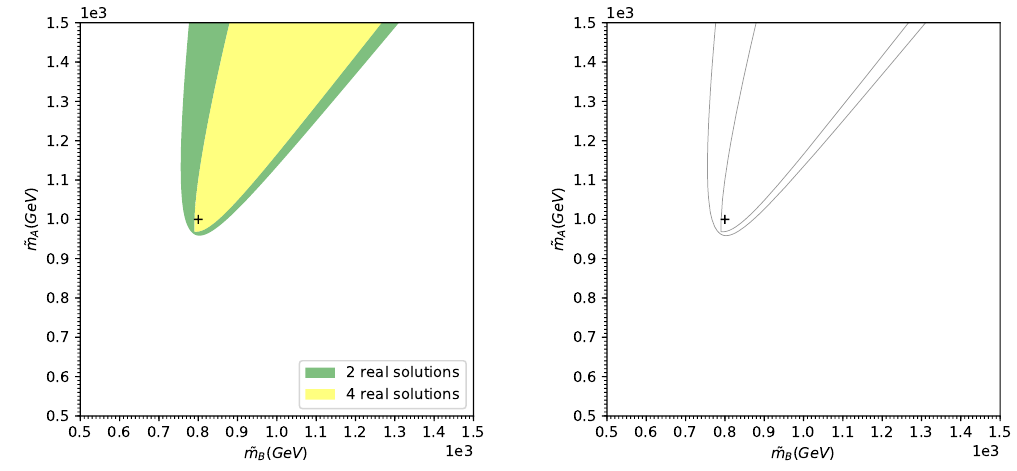
Figure 12 . Illustration of degeneracy curves. We recycle the same event used to make the right panels in (cid:12)gures 2{4. On the left we show the solvability plot for ~ m the right we show the corresponding degeneracy curves. As before, the cross marks the true mass point ( m ; m B A